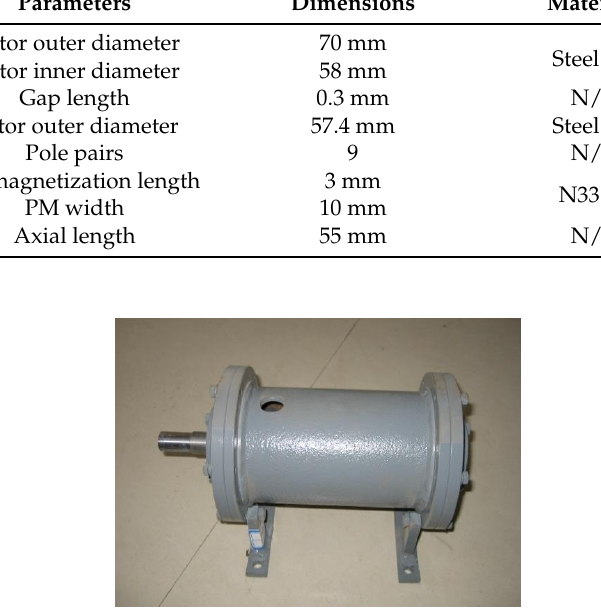
Table 1. Parameters of the prototype.